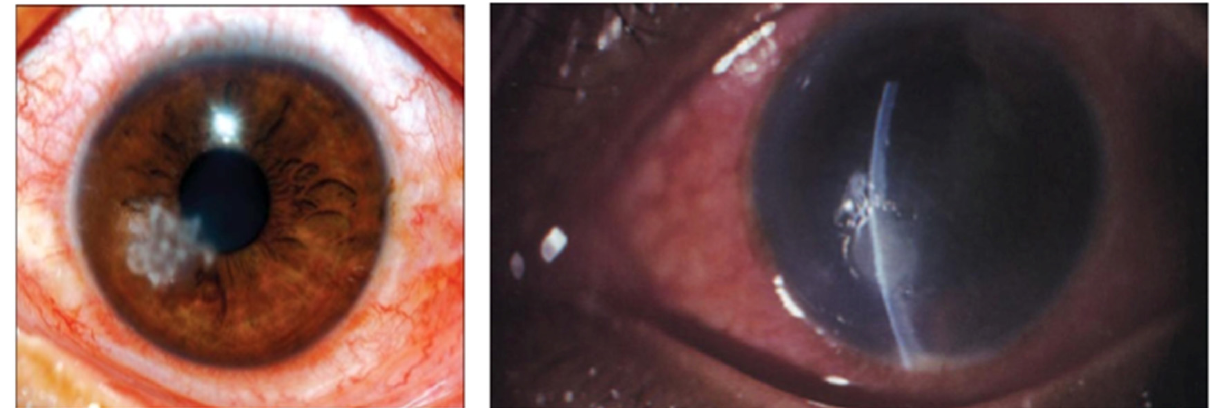
Figure 1. Images showing stromal fungal infiltrates causing fungal keratitis.